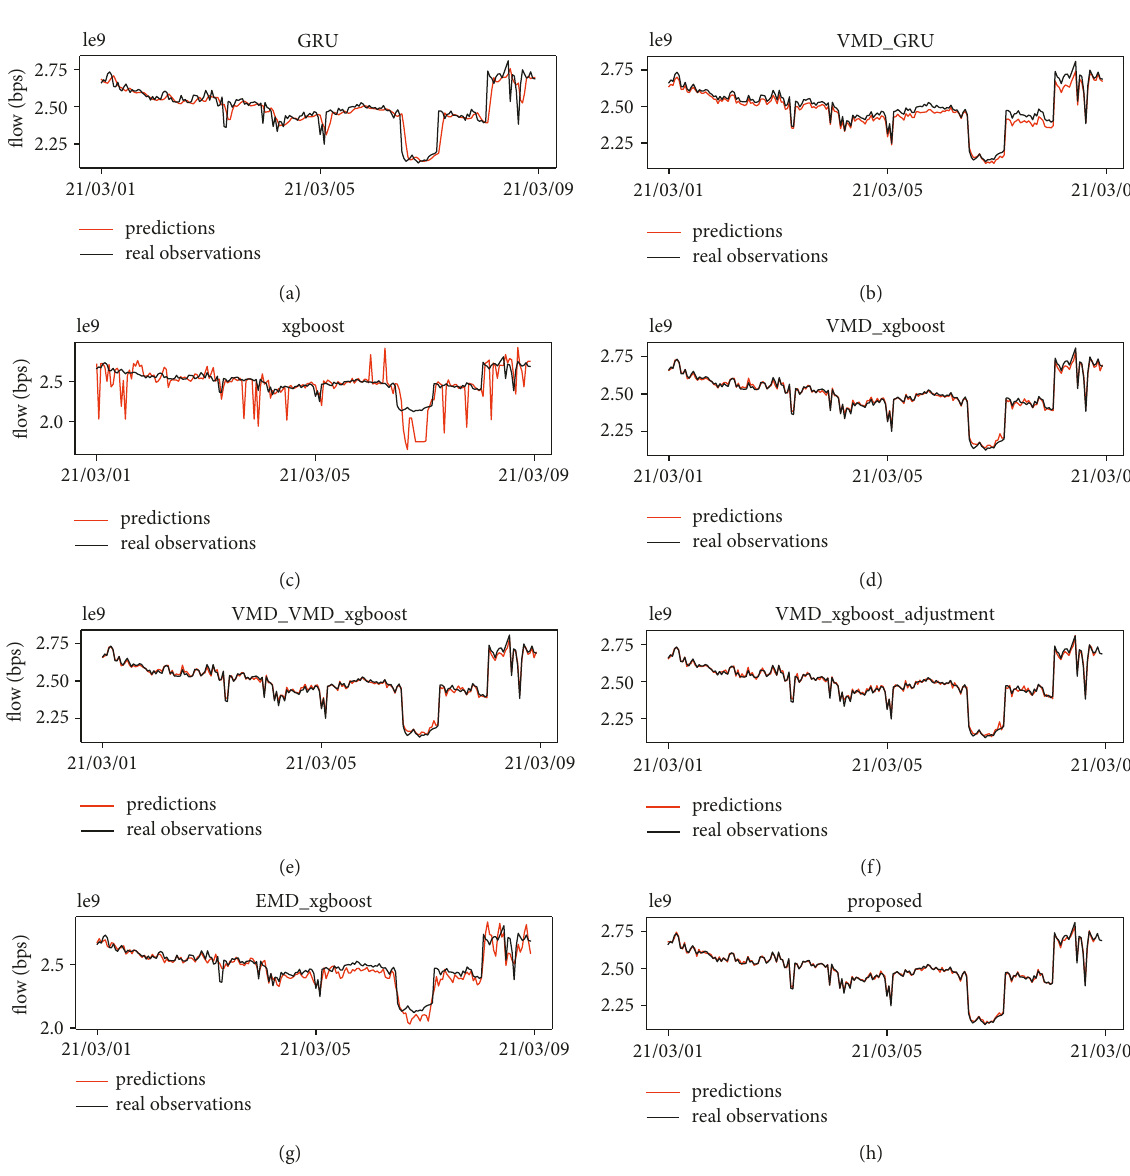
Figure 8: The prediction curves of network outflow flow from all considered